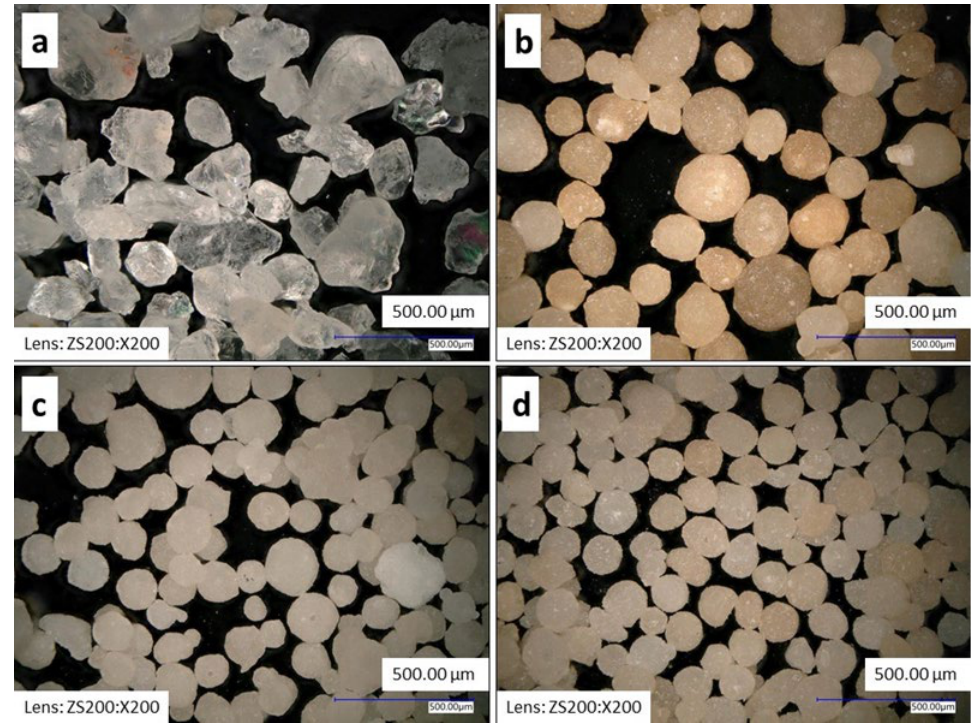
Figure 1. Detailed view of the sands used captured on a Keyence VHX 6000 digital microscope: ( a )